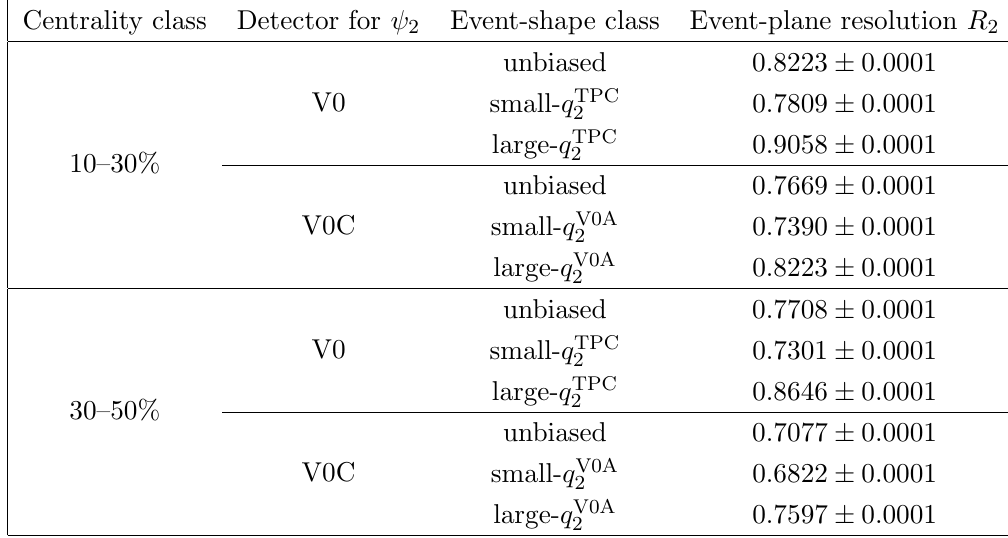
Table 1 . Event-plane resolution R 2 in the 10{30% and 30{50% centrality classes for the unbiased, small- q 2 and large- q 2 samples. The quoted uncertainty is statistical